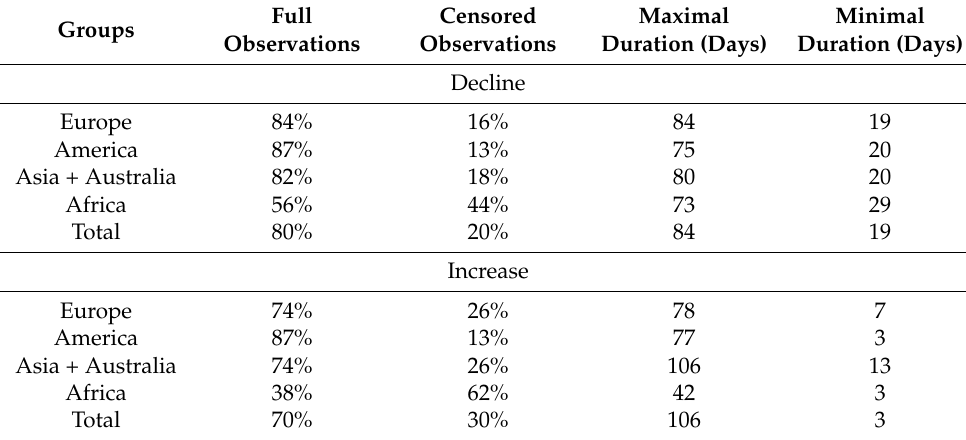
Table 1. Structure of indices with respect to the achieved limit values and continents ( N = 108). Source: own elaboration.